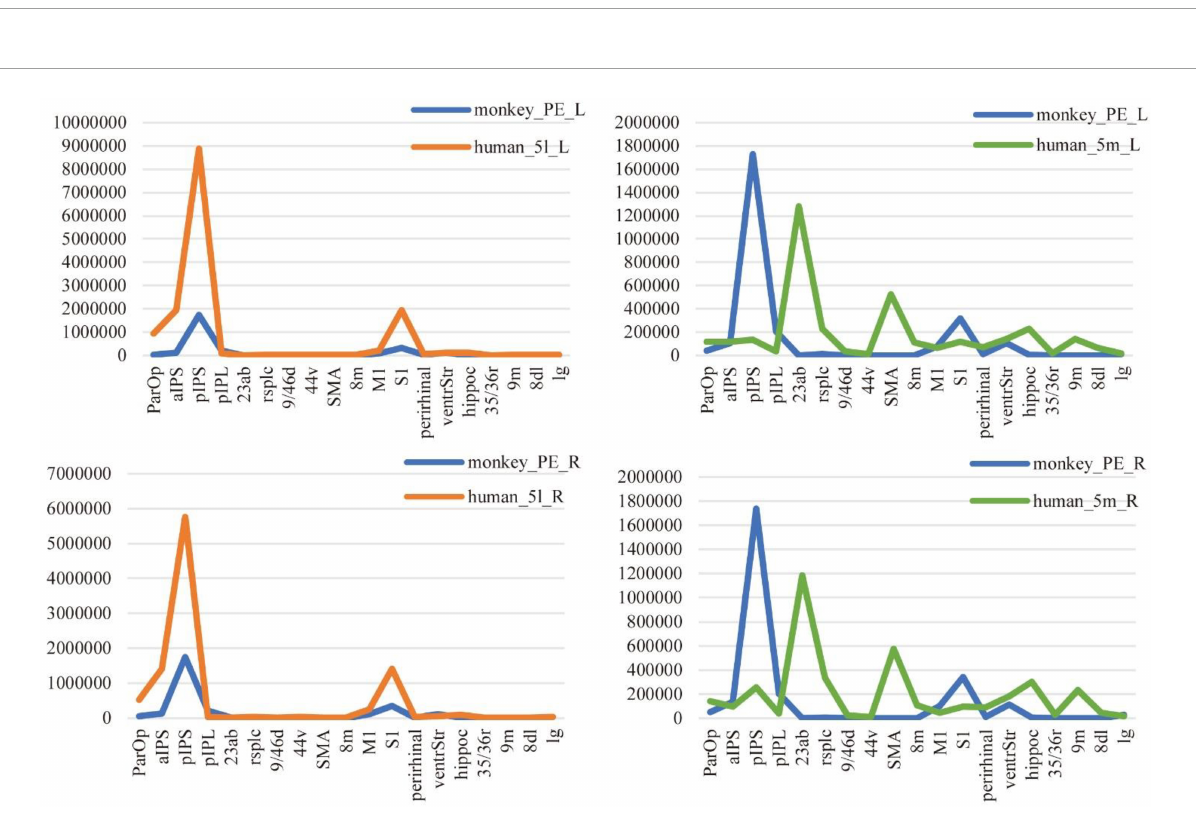
FIGURE6 Comparison of anatomical connections between 5L and 5m of humans and the PE of macaques. The trend graph and the X-axis are the 19 ROIs selected in the study, and the Y-axis is the connection frequency from the seed area to the target area calculated in the probabilistic fiber tracking. (Here, the probabilistic fiber tracing of both human and macaque brains is set to 20,000 times per voxel point) The upper left corner image shows the connection of the PE region and 5L region to 19 ROIs, in the left hemisphere of the macaque and human brain. The lower left corner image shows the connection of the PE region and 5L region to 19 ROIs, in the right hemisphere of the macaque and human brain. The upper right corner image shows the connection of the PE region and 5m region to 19 ROIs, in the left hemisphere of the macaque and human brain. The lower right corner image shows the connection of the PE region and 5m region to 19 ROIs, in the right hemisphere of the macaque and human